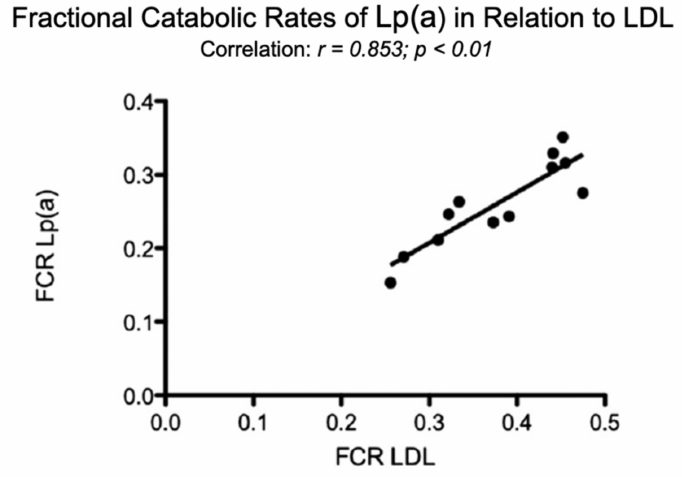
Figure 5. Fractional catabolic rates (FCR) of Lp(a) in relation to the FCR’s of LDL. Turnover studies, as described in Figure 4, were carried out in 12 individuals with various LDL concentrations and the FCR’s of Lp(a), and LDL were analyzed